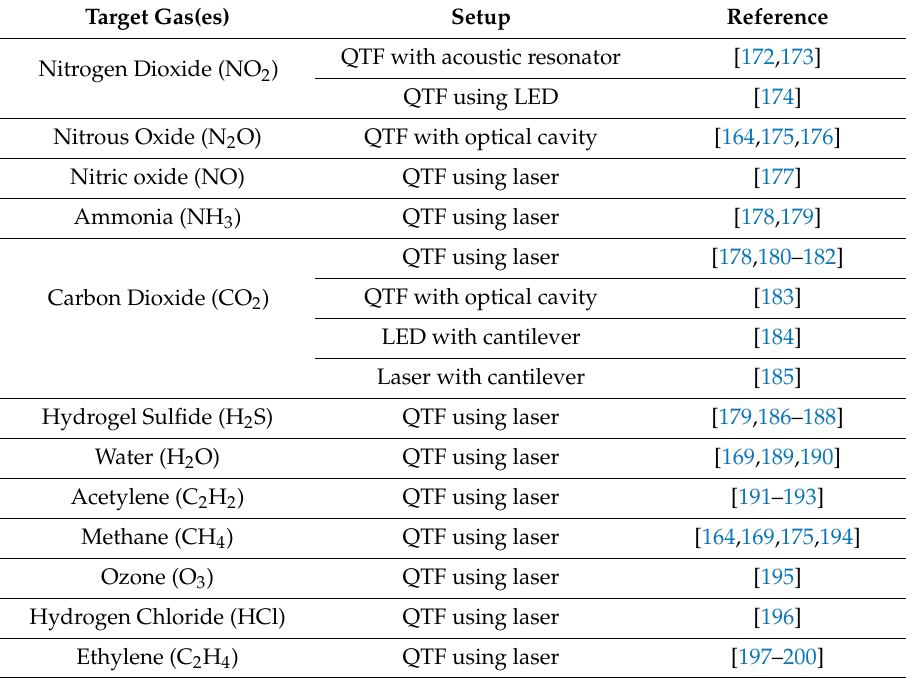
Table 3. An excerpt of past QEPAS / cantilever